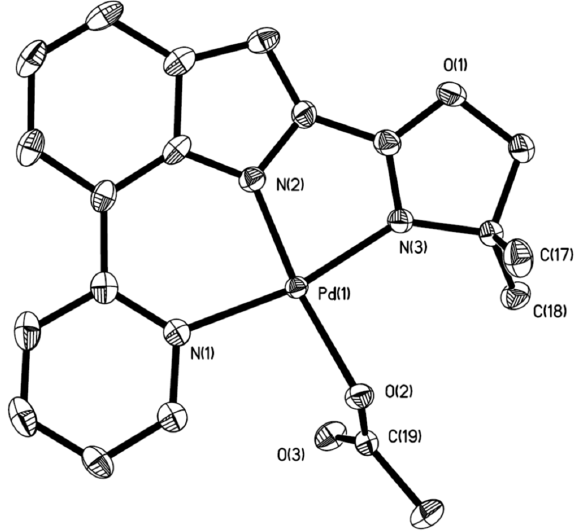
Figure 3. Molecular structure of 5 with thermal ellipsoids drawn at the 30% probability level. Selected bond lengths (Å) and bond angles ( ◦ ): Pd-N(1), 2.087(3); Pd-N(2), 1.923(3); Pd-N(3), 2.050(3); Pd-O(2), 2.048(2); N(2)-Pd-N(1), 89.01(11); N(2)-Pd-N(3), 79.33(11); N(3)-Pd-N(1), 168.21(10); O(2)-Pd-N(1), 97.83(10); O(2)-Pd-N(2), 171.82(10); O(2)-Pd-N(3), 93.66(10). Hydrogen atoms omitted for clarity.